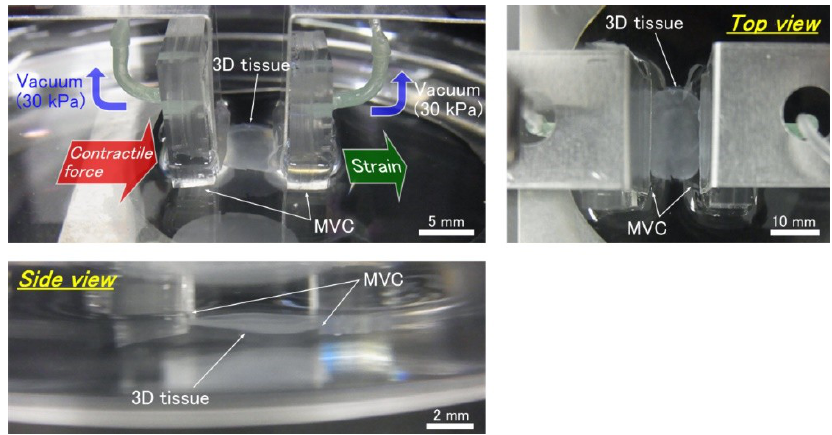
Figure 7. Photos of the cardiac 3D tissue fixed by the micro vacuum chuck (MVCs). Both ends of the cardiac 3D tissue were connected to the force transducer and the motorized stage with the MVCs which applied a vacuum pressure of 30 kPa. Micromachines 2019 , 10 , x FOR PEER REVIEW